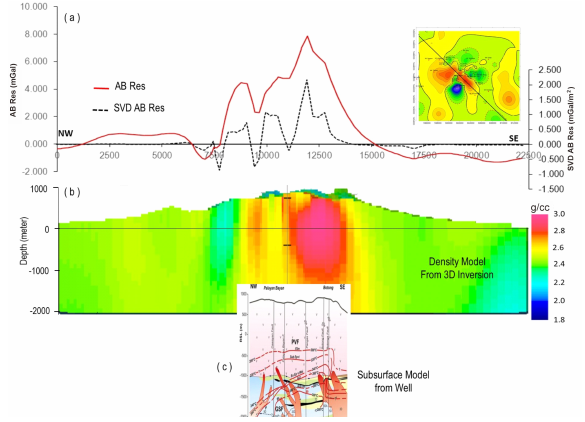
Fig. 11. The subsurface density distribution model from the 3D inversion modeling result of Bouguer residual anomaly in Bac-Man geothermal field